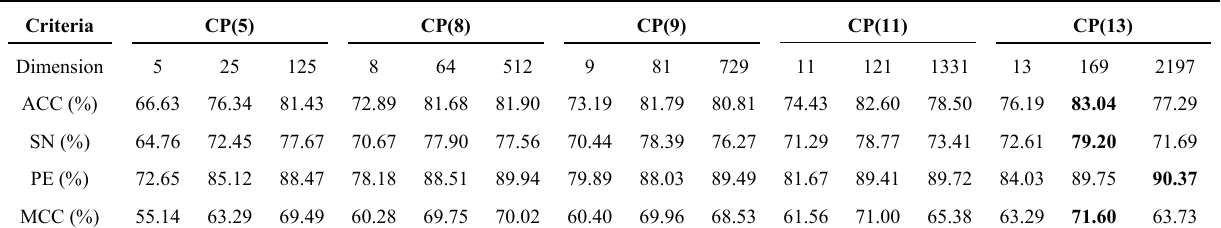
Table 4. Prediction results on the H. pylori dataset. (The numbers in bold is the best result.). Criteria